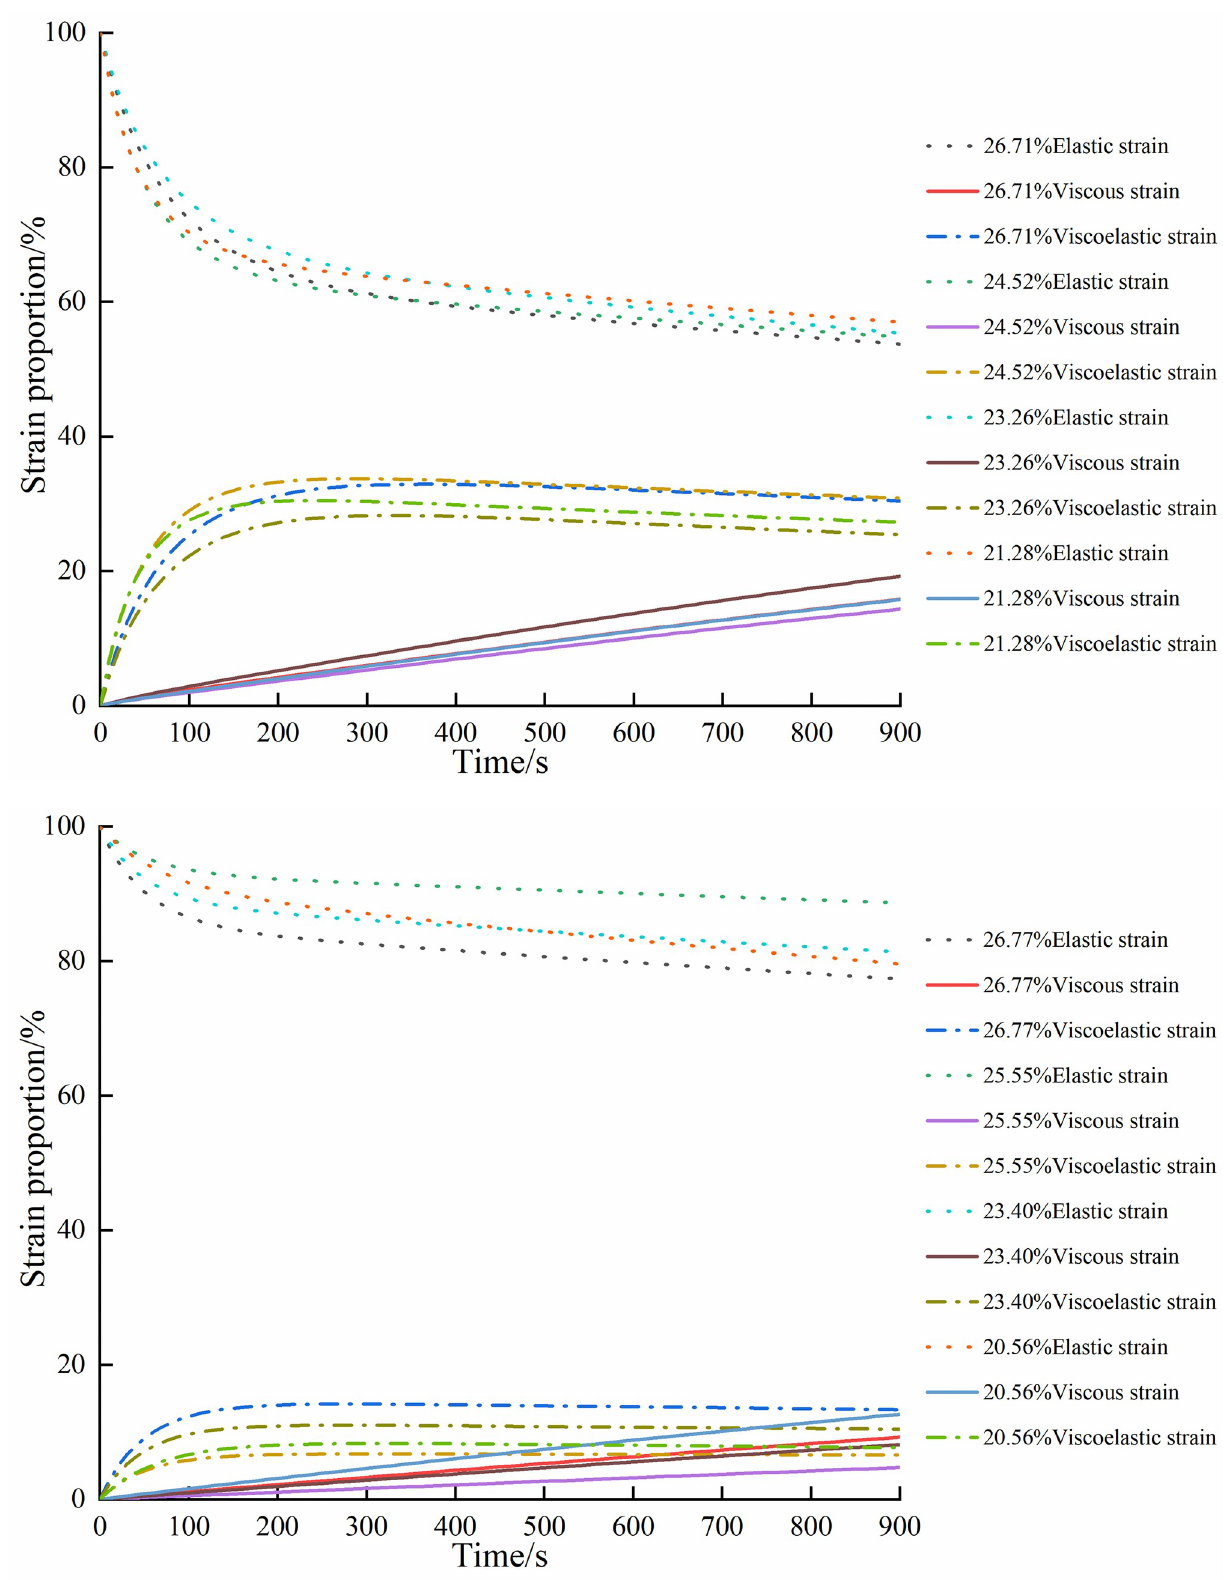
Fig 7. Strain proportion under each moisture content. (a) No tillage; (b) Plough tillage. https://doi.org/10.1371/journal.pone.0253623.g007 PLOS ONE | https://doi.org/10.1371/journal.pone.0253623 June 24,